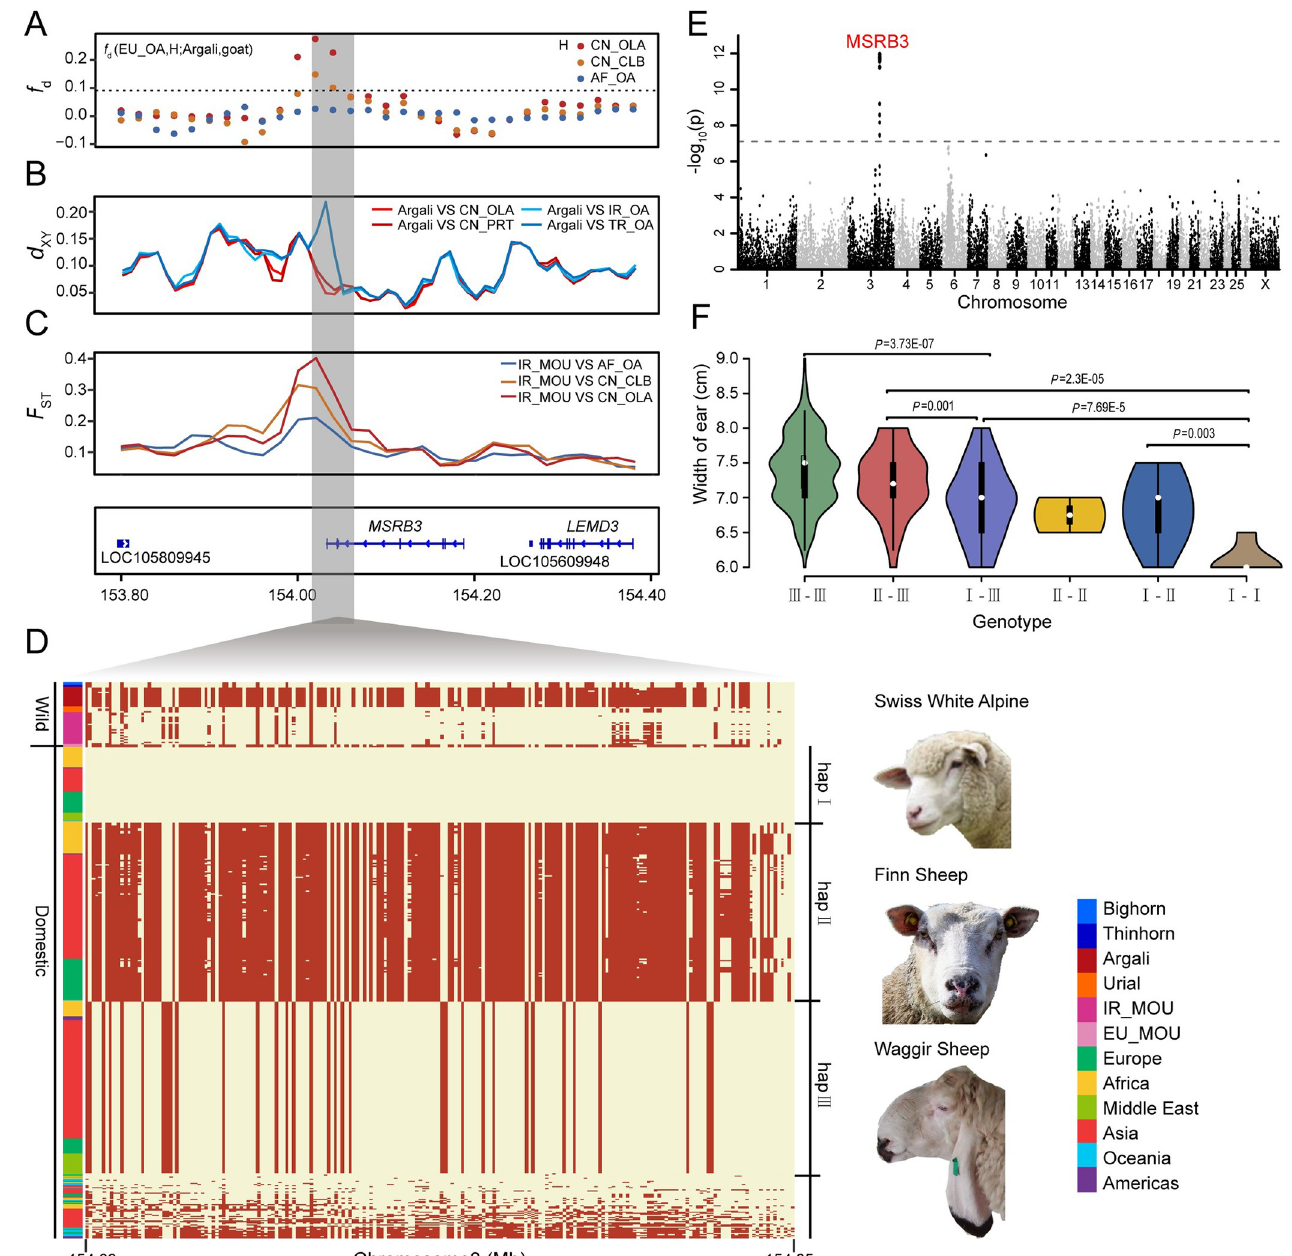
Fig 5. Identification and functional annotation of introgression segment at the MSRB3 locus from argali to domestic sheep. (A-C) Distributions of f d (EU_OA, H; Argali, Goat), d XY values and F ST surrounding the introgressed region (Oar_v4.0 chr3: 153,800,001–154,380,001). The horizontal dashed line in f d track indicate the significance cutoff ( P < 0.001, Z test). (D) Haplotype pattern in the potential introgressed region (chr3: 154,030,048–154,062,195) of MSRB3 gene. Each row is a phased haplotype, and each column is a polymorphic SNP variant. The reference and alternative allele are indicated in light yellow and red, respectively. Hap-II was the introgressed haplotype from argali. Photo credits are showed in S7 Table. (E) GWAS -log10 P values for the width of the external ear of East-Friesian × Hu F2 crossbreds are plotted against position on the chromosomes. The gray horizontal dashed lines indicate the genome-wide significance threshold of the GWAS (7.72 × 10 − 8 ). (F) The violin plots refer to width of external ear for East-Friesian × Hu hybrids with different genotypes. III-III refers to homozygote of hap III defined in Fig 5D, the other five genotypes are denoted accordingly.